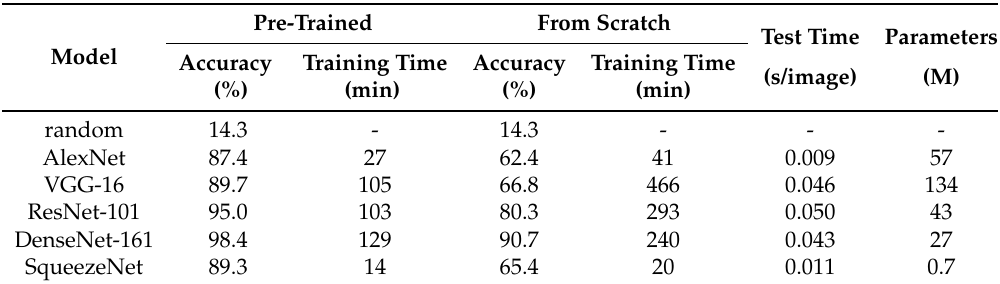
Table 3. Result table for different network architectures. DenseNet-161 outperforms other models in terms of test accuracy by a large margin, which shows its generalization ability due to higher parameter efficiency. The reported accuracy refers to the top-1 accuracy metric on the test